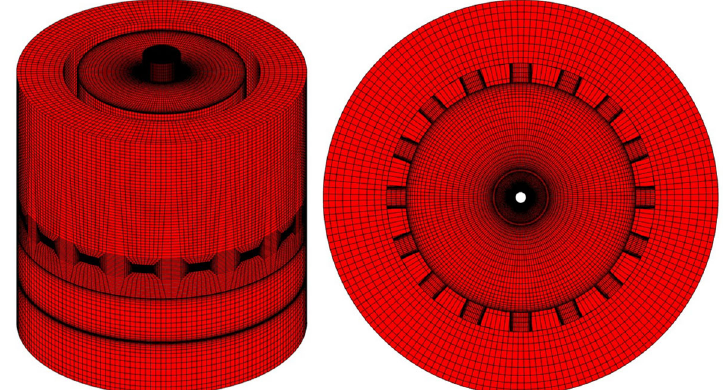
Figure 3. Grid configuration.